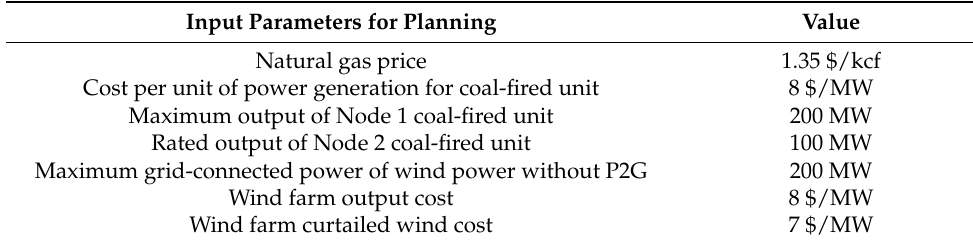
Table A6. Other data. Reproduced from [16,33], Proceedings of the Chinese Society of Electrical Engineering: 2018 and 2017.